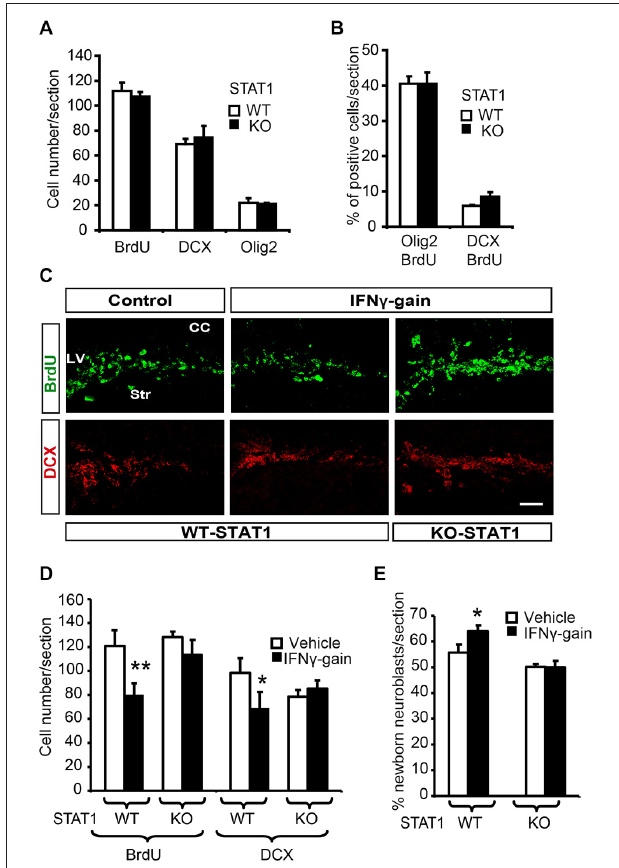
FIGURE 6 | STAT1 mediates IFN γγγ activities in vivo . (A) Quantification summarizes how, in the absence of STAT1, proliferation (BrdU) and the expression of neuronal markers such a DCX and olig2 were unaltered. (B) Histogram representing a similar proportion of newborn determined neurons (BrdU+/DCX+) and glial cells in the SVZ of STAT1-KO animals that received a single BrdU 4 days before sacrifice, ( n = 6). (C) Pictures of the SVZ sections illustrating that STAT1 deficiency impeded IFN γ functions in the in vivo model. The numbers of proliferative cells (BrdU, green) and neuroblasts (red) were unchanged in KO samples in the IFN γ -treated animals. (D) Quantification summarizes how IFN γ effects on proliferation (BrdU incorporation) and neuroblast populations (DCX+ cells) were abolished in the absence of STAT1 mediator ( n = 6). (E) Histogram representing the impossibility of IFN γ inducing neuronal differentiation (BrdU+/DCX+ cells) in STAT1-KO animals that received a single BrdU administration 4 days before sacrifice. ( n = 6). Scale bar: 50 µ m. Data are represented as mean ± SEM. * p < 0.05; ** p ≤